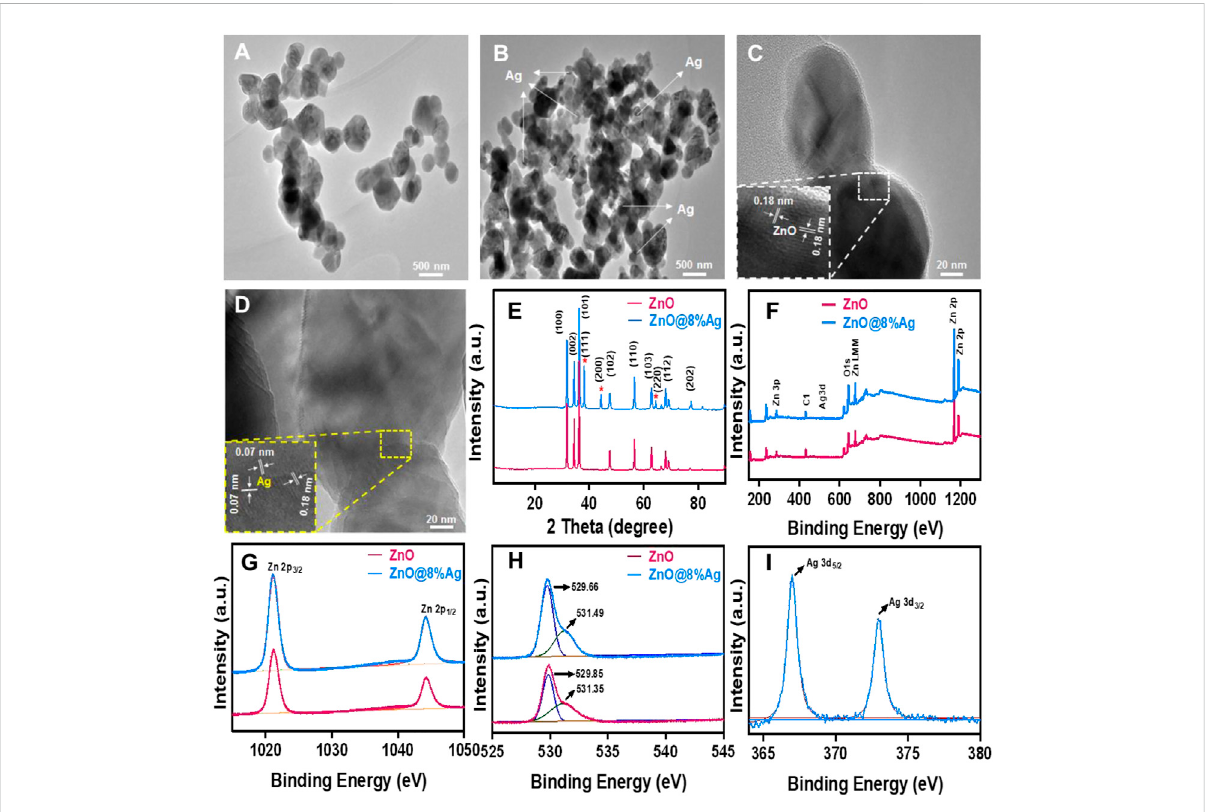
FIGURE 1 Characterization of ZnO and ZnO@8%Ag. (A,B) TEM images, (C,D) HRTEM images, (E) X-ray diffraction (XRD) patterns, (F) full XPS survey spectrum of ZnO and ZnO@8%Ag, (G) XPS spectra of Zn 2p region, (H) O1s region, (I) Ag 3d